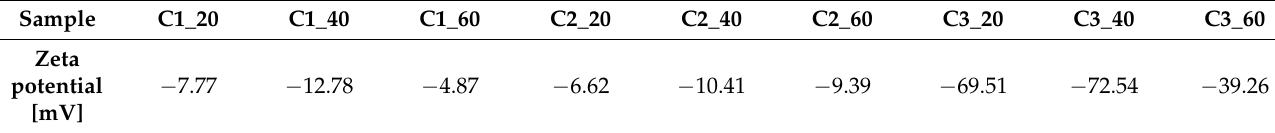
Table 4. Zeta potential values for the synthesized